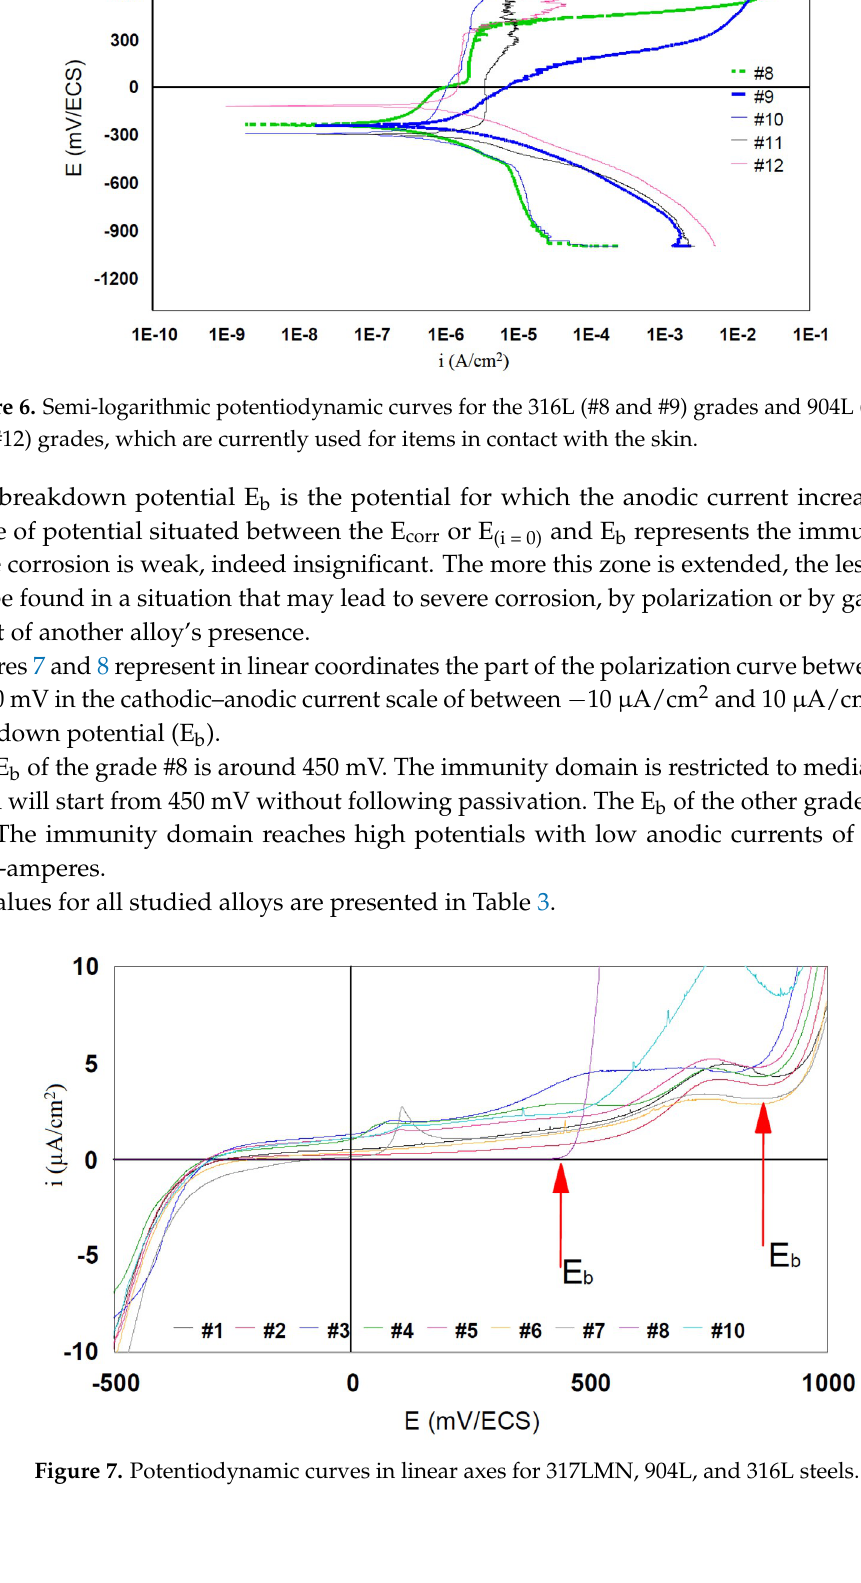
Figure 8. Linear potentiodynamic curves of 316L (#8 and #9) and 904L (#9, #10, and #11) steels, usually used in watchmaking. E b values for all studied alloys are presented in Table 3. The results of the generalized corrosion test point out three basic groups. All of the 317LMNs were similar. The tested 316L steels were noticeably worse. The 904Ls were difficult to discern, but